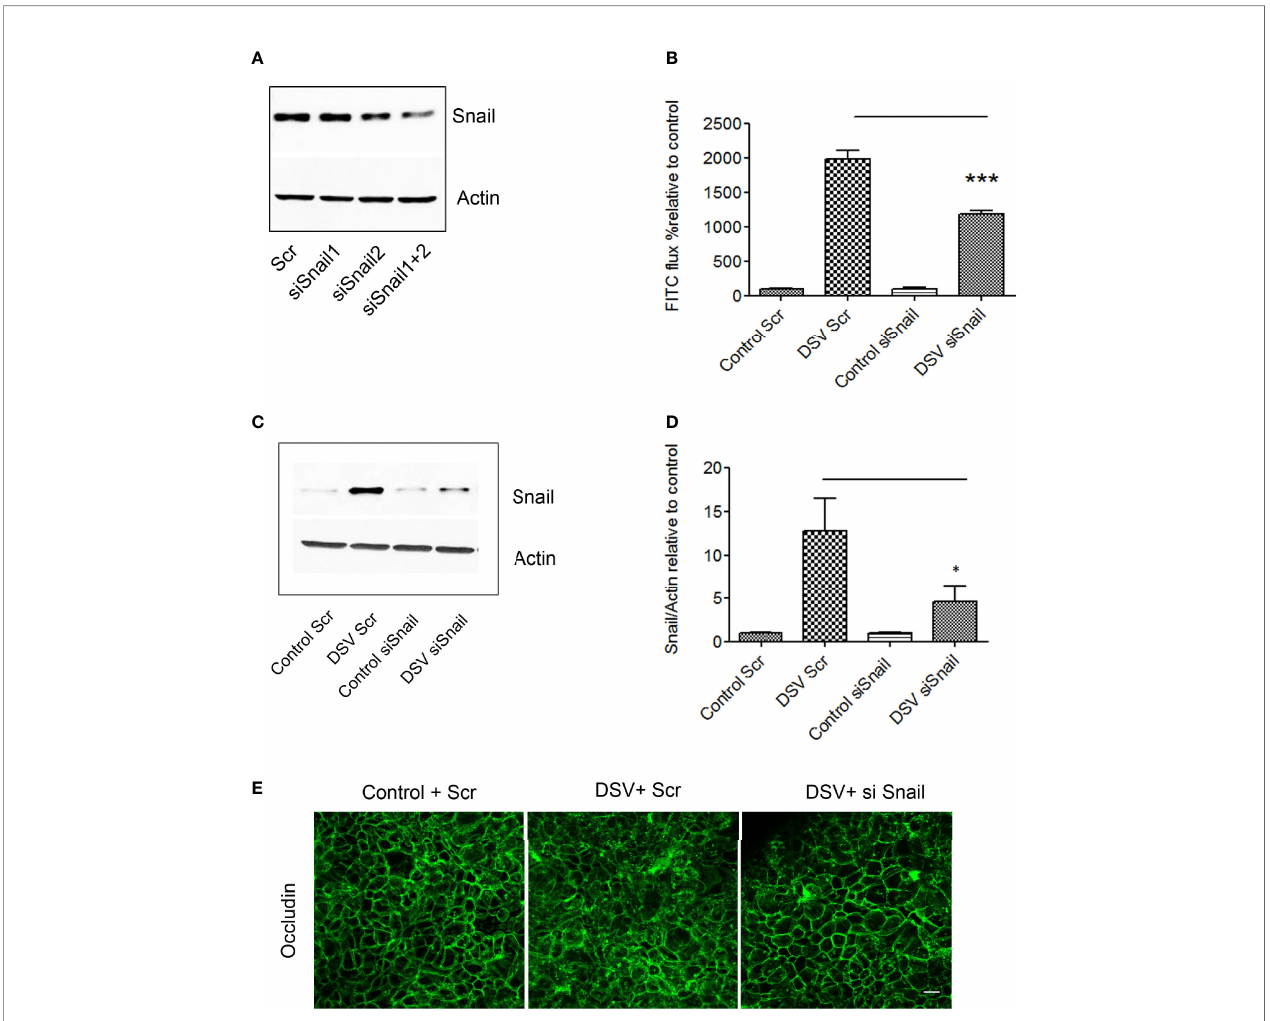
FIGURE 4 | DSV induced permeability in snail-dependent fashion. Polarized Caco-2 cells were transfected with either scrambled control (Scr) siRNA or siRNA against snail (siSnail) for 48 hours. (A) transfection ef fi ciency was determined by Western blotting in cells transfected with two siRNAs against snail alone or in combination. (B) Transfected cells were infected with DSV for further 24 hours. After 24 hours, FITC-Dextran was added on the apical side of the cells for 1 hr following which 100 m l of medium from the basolateral surface was collected and analyzed for FITC- fl ux. ***p < 0.001. (C) Snail expression was monitored by Western blotting in transfected cells challenged with DSV. (D) Graph represents Mean ± SEM from at least 3 independent experiments. *p<0.05. (E) Polarized Caco-2 cells were transfected with either Scr or Snail siRNA for 48 hours. This was followed by DSV infection for 24 hours. Cells were then fi xed with 4% paraformaldehyde and probed by immuno fl uorescence for occludin staining as described in Materials and Methods. Images were collected as Z-stacks that were compressed at the end to generate the fi nal images. Scale bar=20